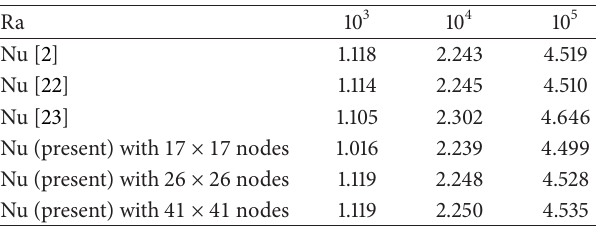
Table1:ComparisonofmeanNusseltobtainedbypresenttechnique with benchmark solutions of De Vahl Davis [2], Barakos et al. [22], and Fusegi et al. [23] for natural convection within a square